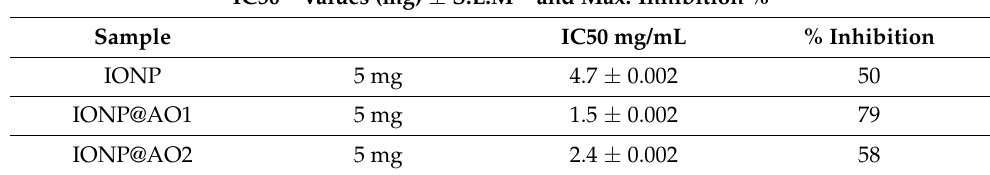
Figure 11. UV-visible spectra, DPPH Scavenging percentage by IONP@AO at different concentrations. Table 5. IC50 of IONP@AO.